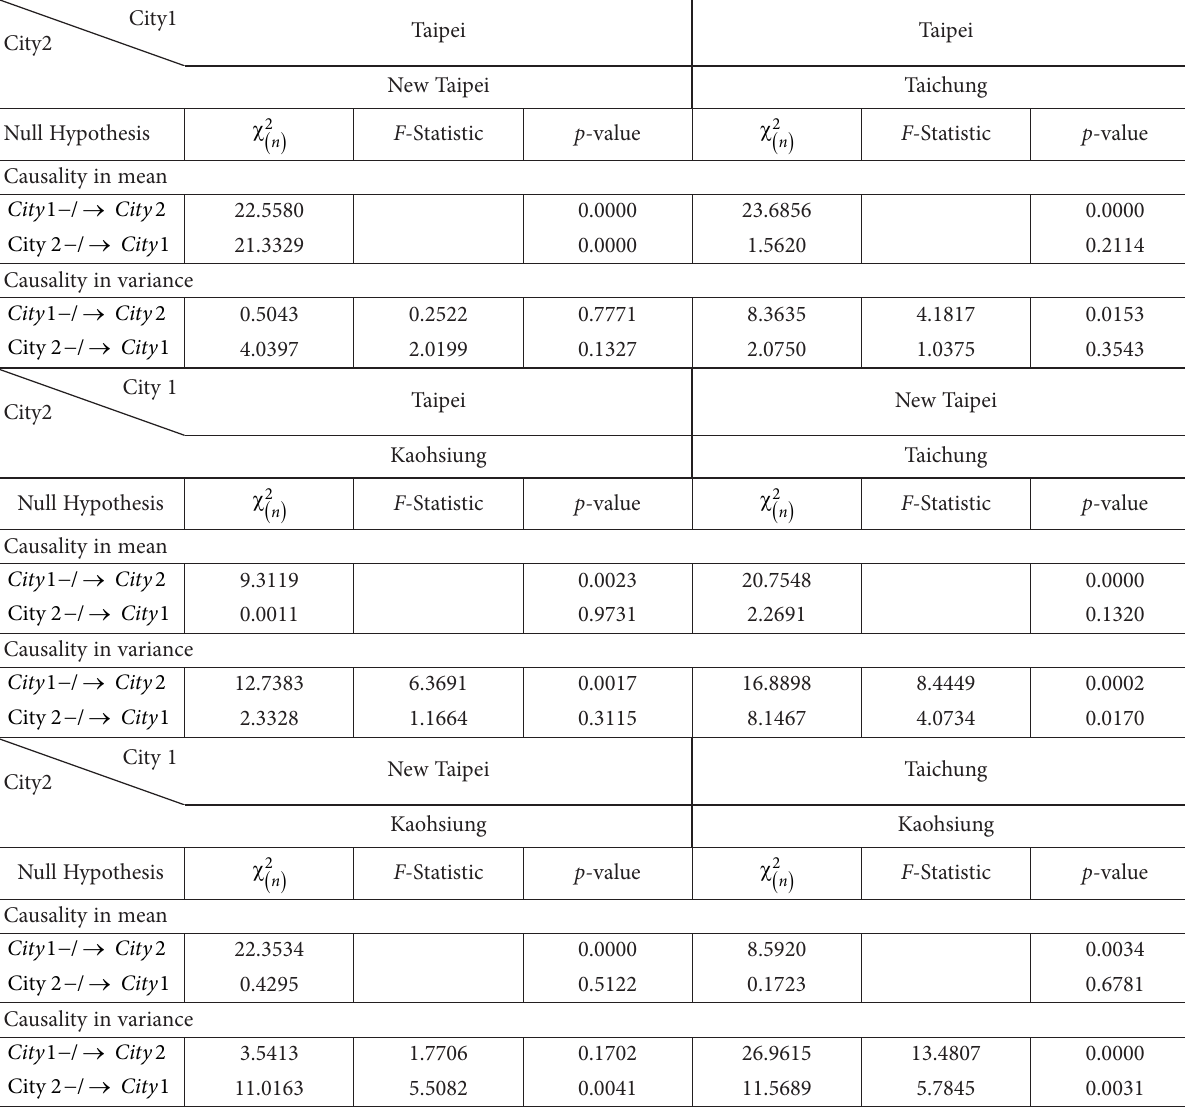
Table 6. Causality tests for the two cities’ housing markets